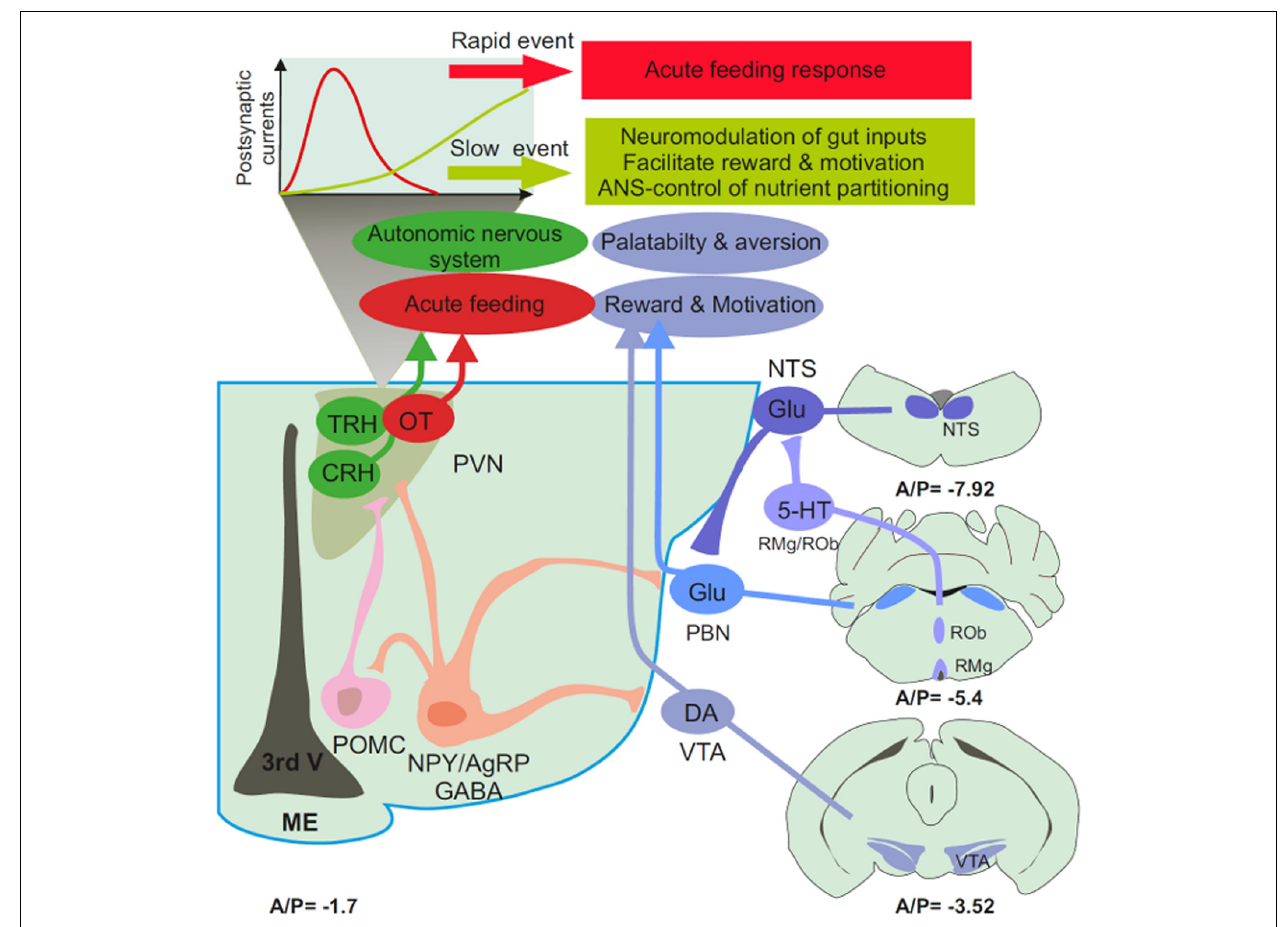
after the propagation of action potential.The timescale of this electrical event is compatible with the neuromodulation of post-synaptic targets including the VTA, the PBN, and preganglionic structure of the PVN. Hence, hunger-activated neurons could have a role that extends beyond the acute regulation of feeding to autonomic control of nutrient partitioning, the modulation of gut-borne signals in the brainstem, and the fine tuning mesolimbic reward and motivational circuitry. (A/P) Antero-posterior stereotaxic coordinates are presented in mm from bregma below each